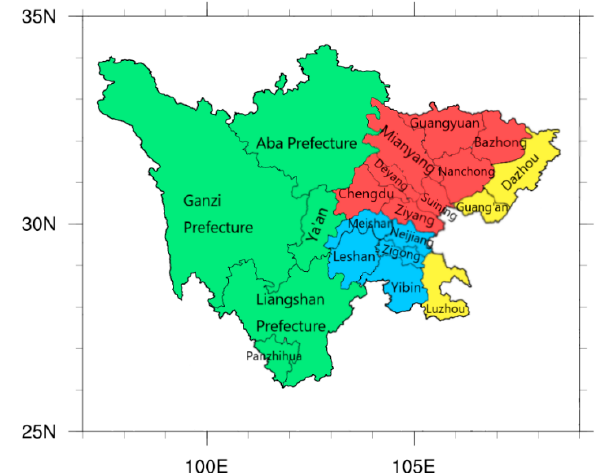
Figure 1. Four areas of Sichuan Province: western Sichuan (green part), northern Sichuan (red part), eastern Sichuan (yellow part), southern Sichuan (blue part). Table 1. AQI category and health implications according to ambient air quality index (AQI) technical regulations (trial) (HJ 633-2012).